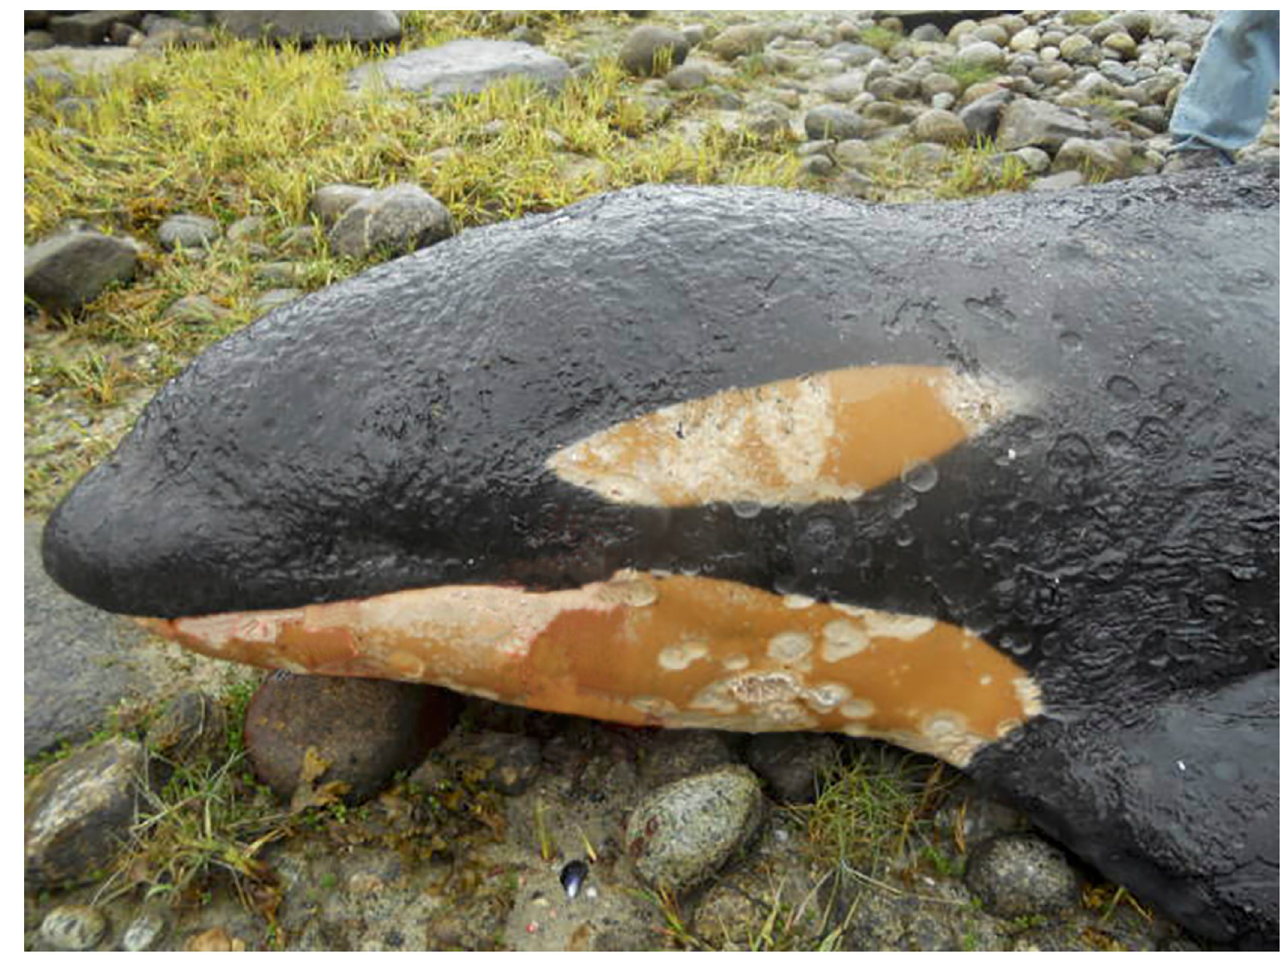
Fig 2. A northern resident calf (ID# 20110522) that died of emaciation due to a congenital cranio-facial